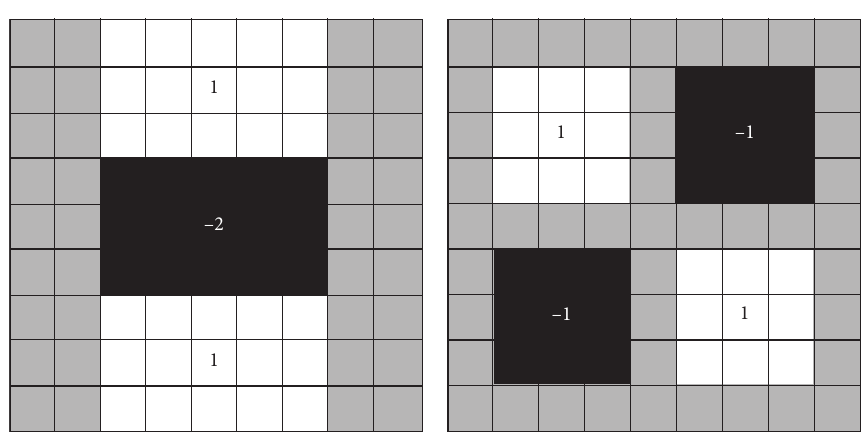
Figure 4: Approximations of L